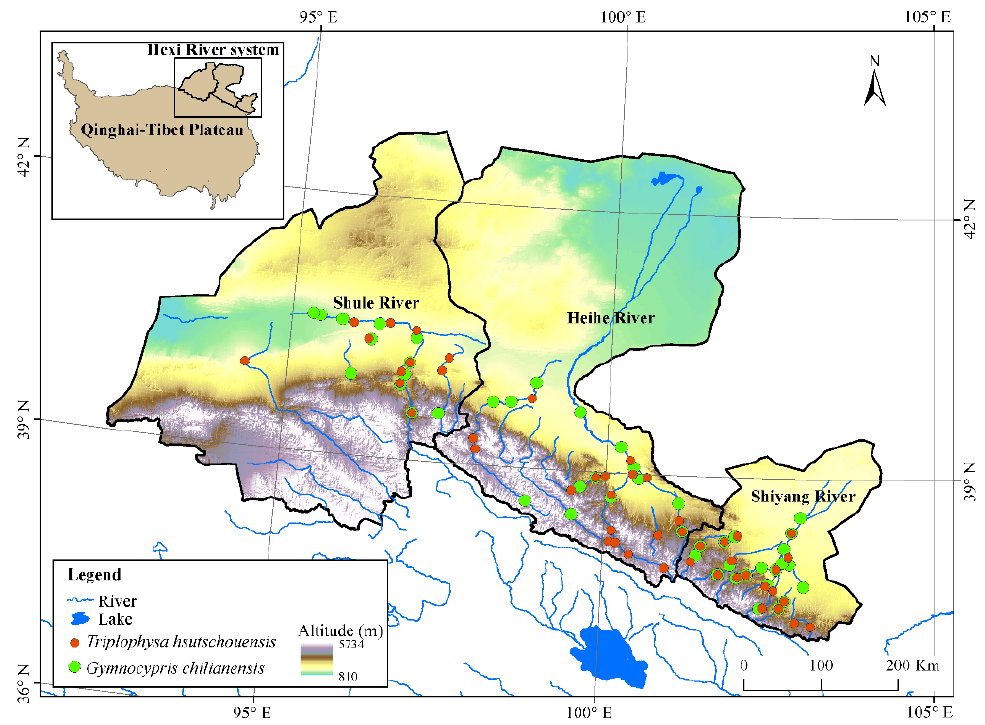
Figure 1. Study area and distribution records of Gymnocypris chilianensis and Triplophysa hsutschouensis . Data sources for fish monitoring points are presented in “Materials and Methods”.